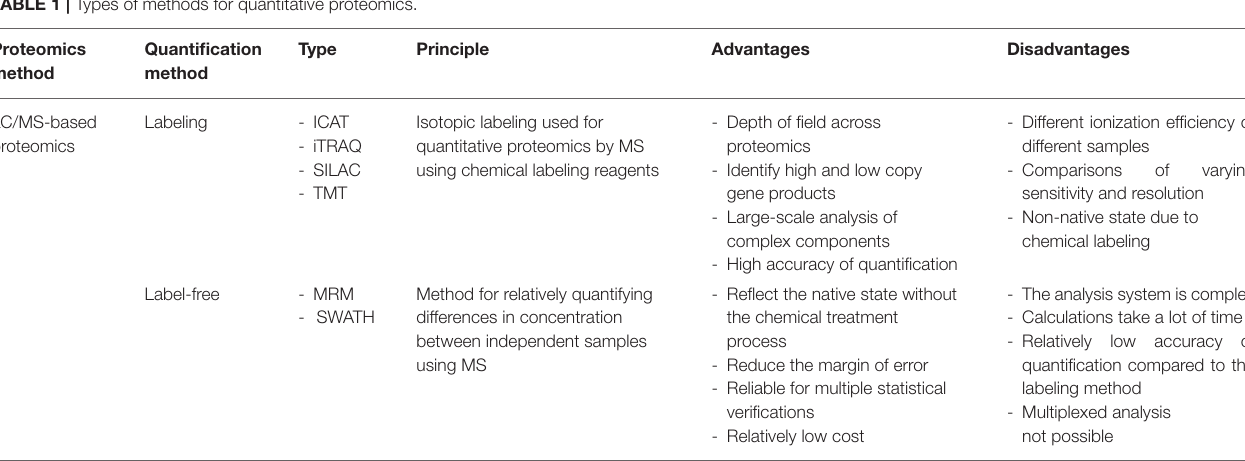
TABLE 1 | Types of methods for quantitative